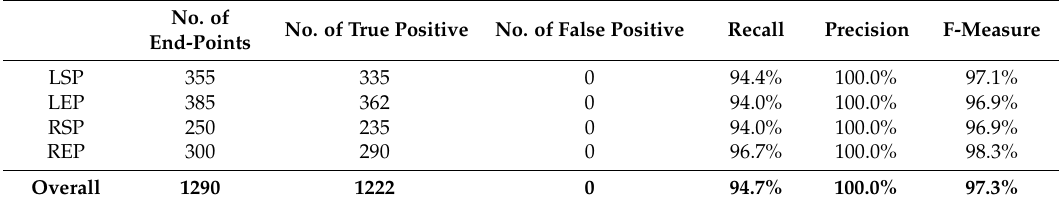
Table 6. Performance of the proposed lane endpoint detection method in